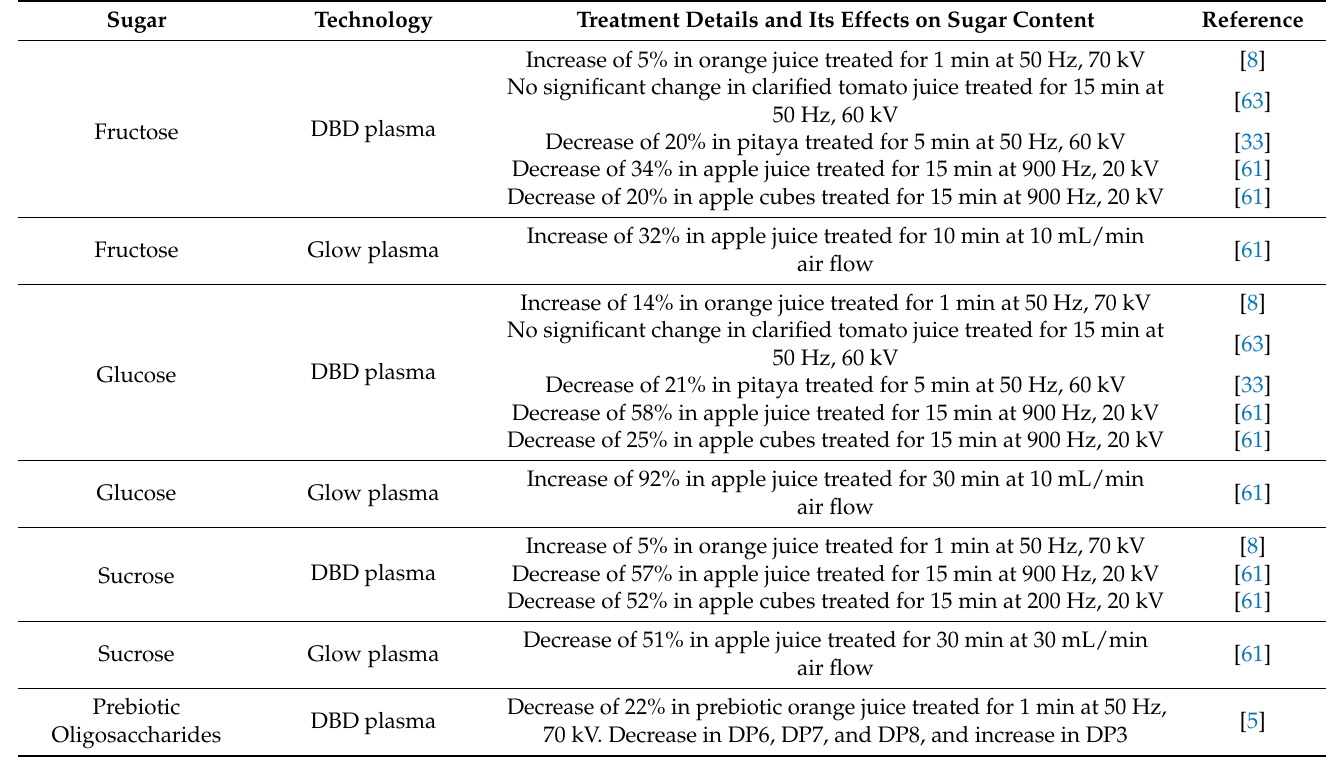
Table 1. Changes in sugars induced by cold plasma